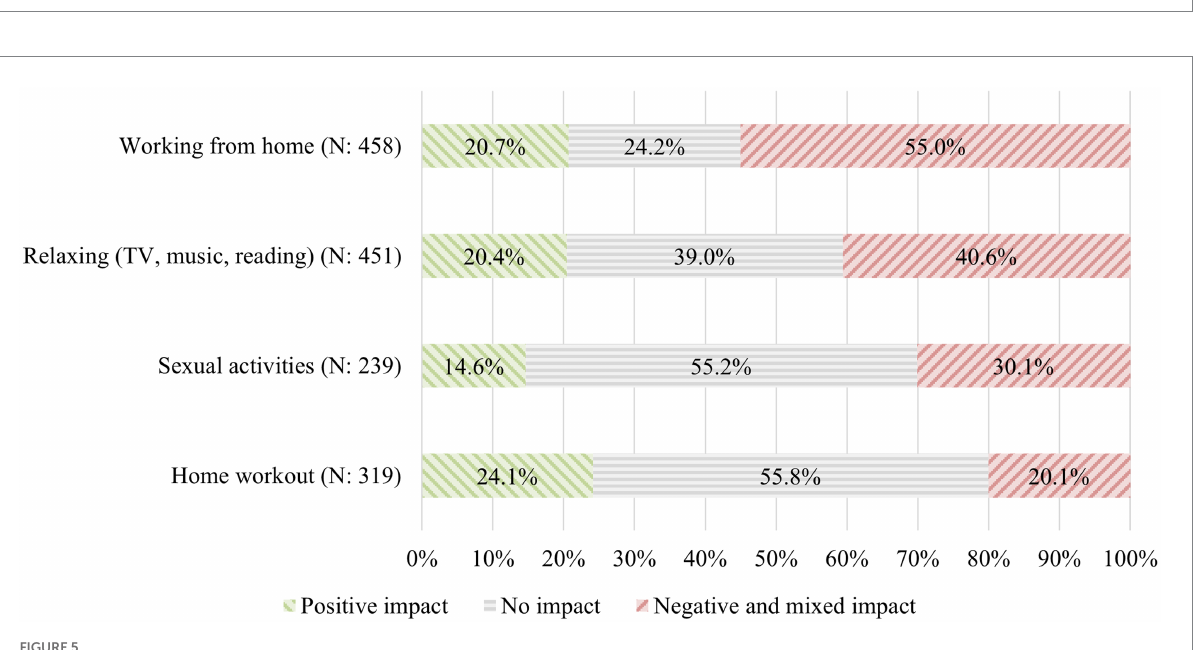
FIGURE 5 Percentage of respondents who reported a positive impact, no impact, and negative or mixed impacts of the noise environment on WFH, relaxation, sexual activities, and home